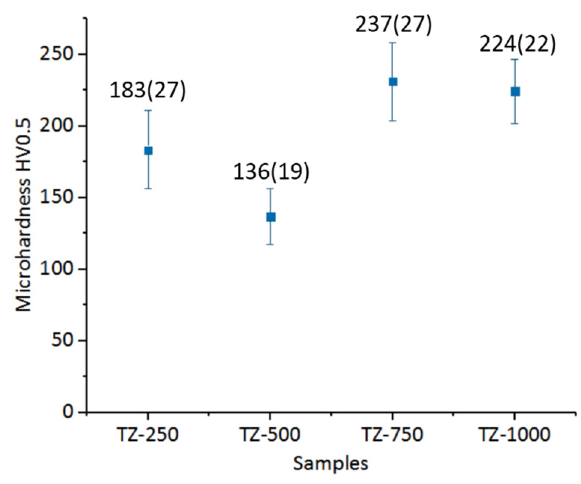
Figure 7. Microhardness values of the obtained materials.